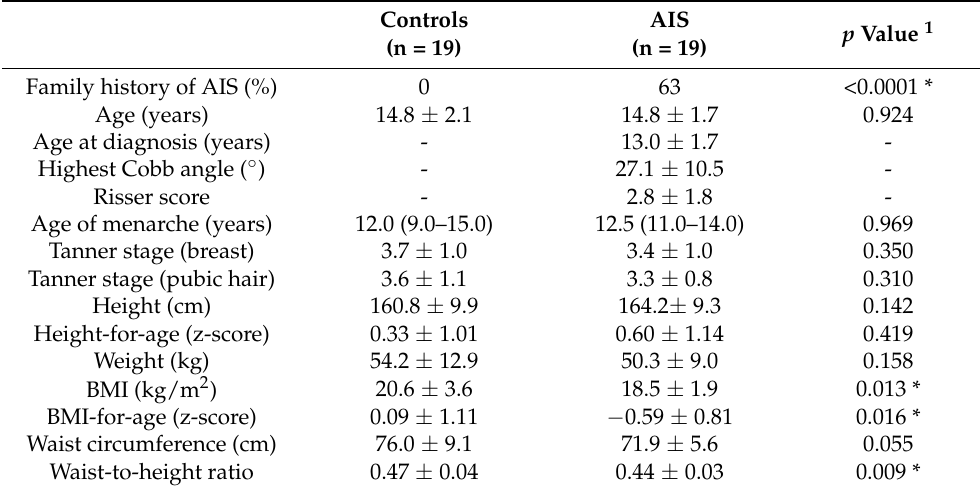
BMI: Body mass index; AIS: Adolescent idiopathic scoliosis. Corrected height was used for AIS par- ticipants. Data are presented as mean ± SD or median (range). 1 Data were compared using a chi- square test, paired t-test, or Wilcoxon matched-pairs signed rank test for non-normally distributed variables. * p < 0.05. Participants underwent a full-body DXA scan to precisely determine their BMD and body composition. Table 2 shows that, compared to controls, girls with AIS had lower total body less head and lower femoral neck BMD z-score, but no statistically significant difference was observed at the lumbar spine site. Also, AIS girls had lower total body fat percentage, fat mass, and fat mass index than controls. Lean mass and lean mass index were similar between groups.